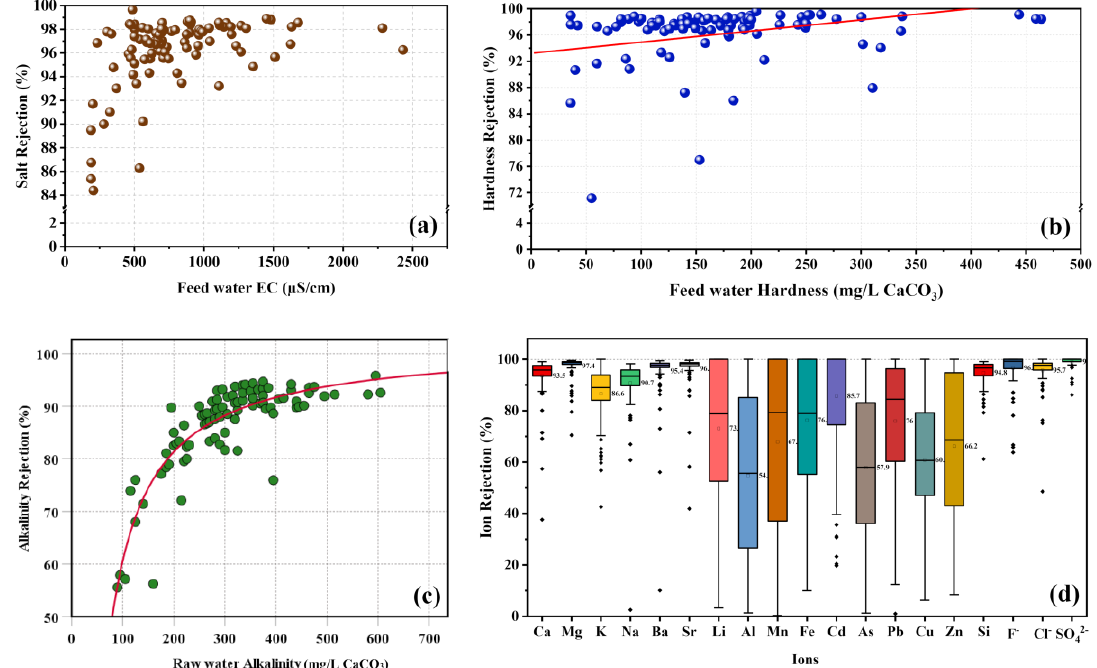
Figure 3. Performance of RO stations: ( a ) the salt rejection variation with the feed water EC; ( b ) hardness rejection efficiency with the feed water hardness; ( c ) alkalinity rejection rates with corresponding feed water alkalinity; ( d ) rejection of individual ions and silicon.